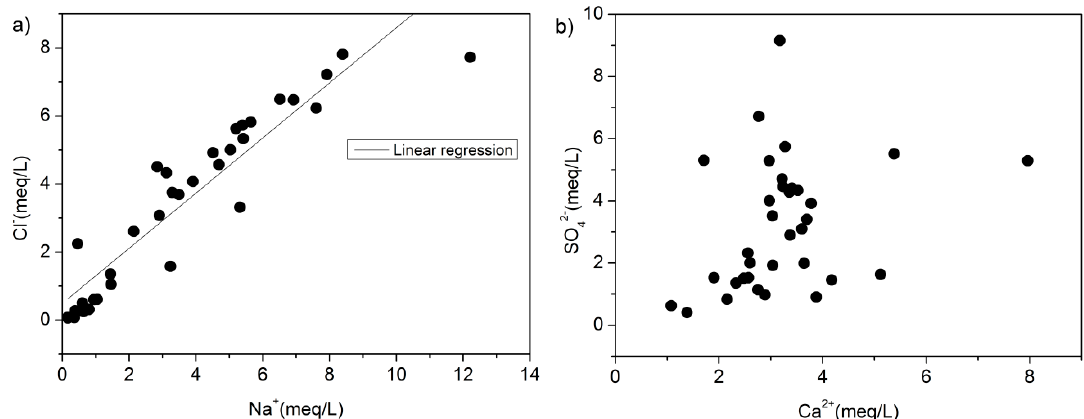
Figure 4. Relationship between Na + and Cl − , SO 42 − and Ca 2+ concentrations of surface waters.